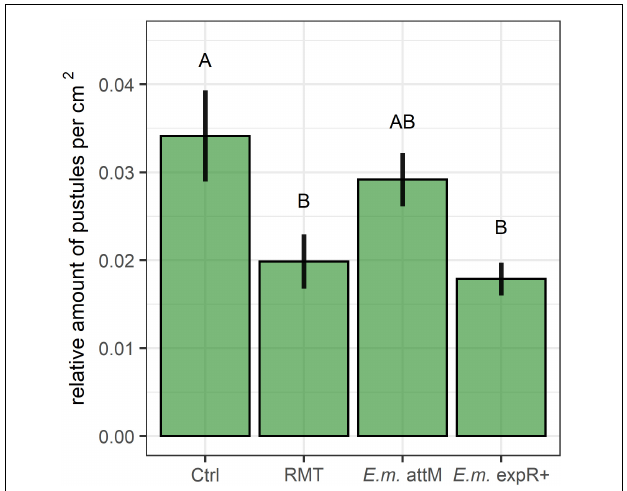
FIGURE 2 | Bgh challenge rate decreased after rhizosphere microbiome transplantation. Effects of inoculation on the relative amount of Bgh pustules per cm 2 were determined in a detached leaf assay. Barley was either treated with the rhizosphere microbiome transplant (RMT) from field soil or saline (0.3% NaCl) as control (Ctrl). Inoculation of the Ensifer meliloti ( E.m .) strains expR + (resistance inducing) and attM (control) was used as internal positive control. Bars represent mean ± SE of four independent experiments ( n = 10, except for the first repetition n = 8). Different letters indicate significant differences (Tukey’s test; p ≤